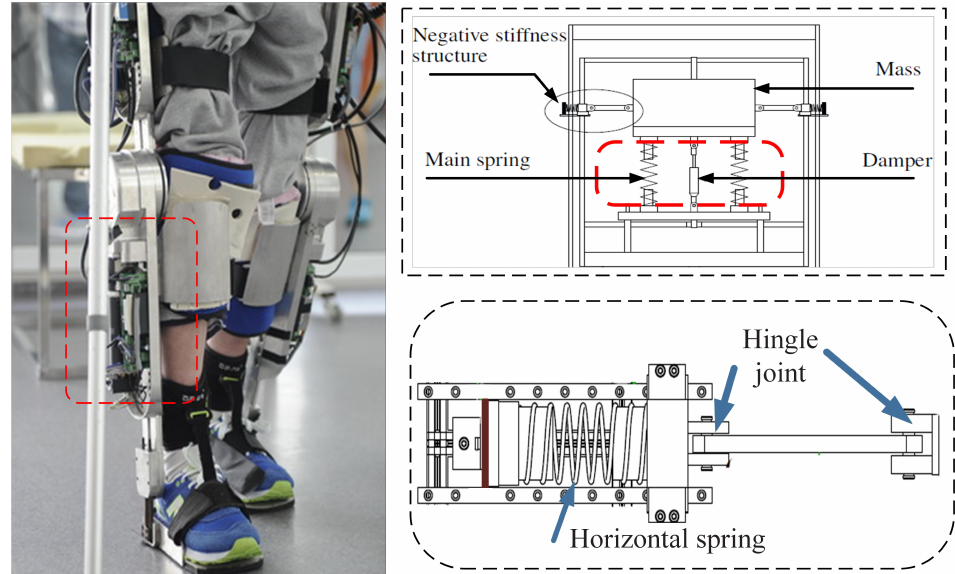
Figure 1. A simplified technical drawing of the NSS and exoskeleton